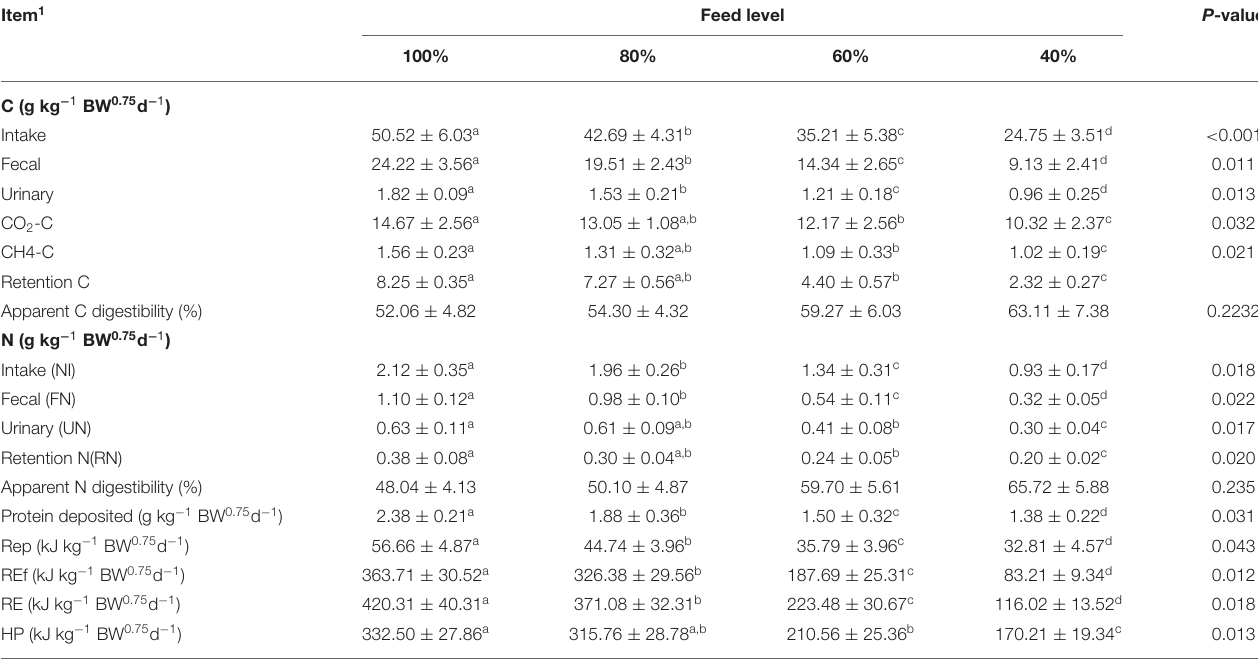
TABLE 4 | Effect of feed intake on carbon (C) and nitrogen (N) balances (g kg − 1 BW 0.75 d − 1 ), heat production (HP) (kJ kg − 1 BW 0.75 d − 1 ), and retained energy (RE) (kJkg − 1 BW 0.75 d − 1 ) by sika deer.